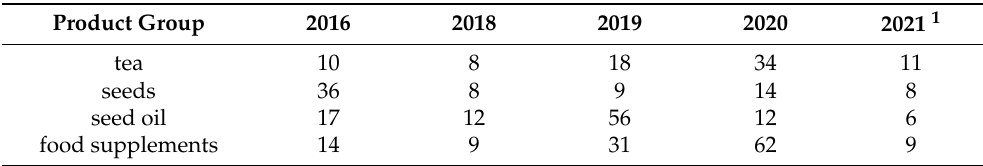
Figure 2. Mean daily intake of ∆ 9 -tetrahydrocannabinol (THC) of hemp tea, hemp seeds, hemp seed oil, and hemp food supplements for 2016, 2018, 2019, 2020, and 2021 compared to the acute reference dose (ARfD) and lowest observed adverse effect level (LOAEL) for a person with a body weight of 70 kg, assuming the daily consumption shown in Table 2. Data for 2016, 2018, 2019, 2020, and the first half of 2021 were used. Table 3. Number of samples of hemp tea, hemp seed oil, hemp seeds, and hemp food supplements